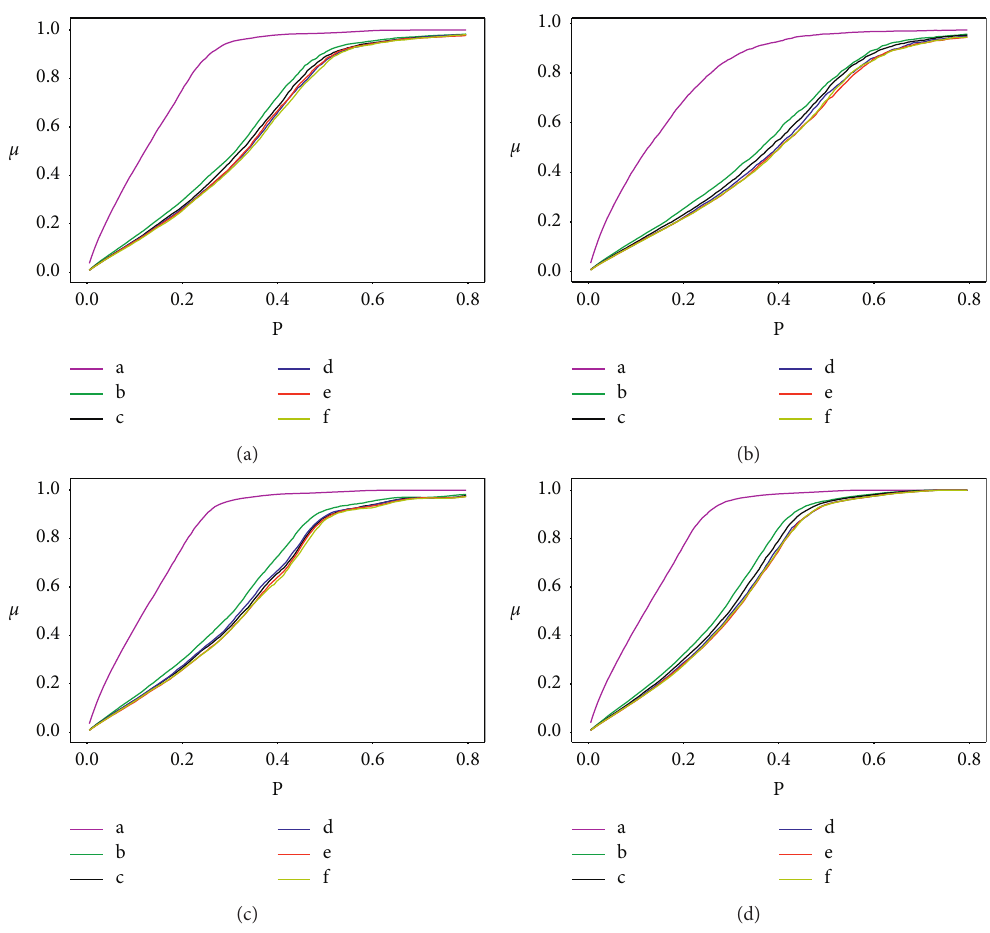
Figure 6: The change of the maximum connectivity coefficient G after model B is attacked by different algorithms, where N � 200, M � 3, curve a represents the BA network, and curve b-f represents the comparison of different parameters of model B (threshold � 0.1–0.5, changes � 0.001). (a) deg, (b) SL, (c) LLS, and (d)